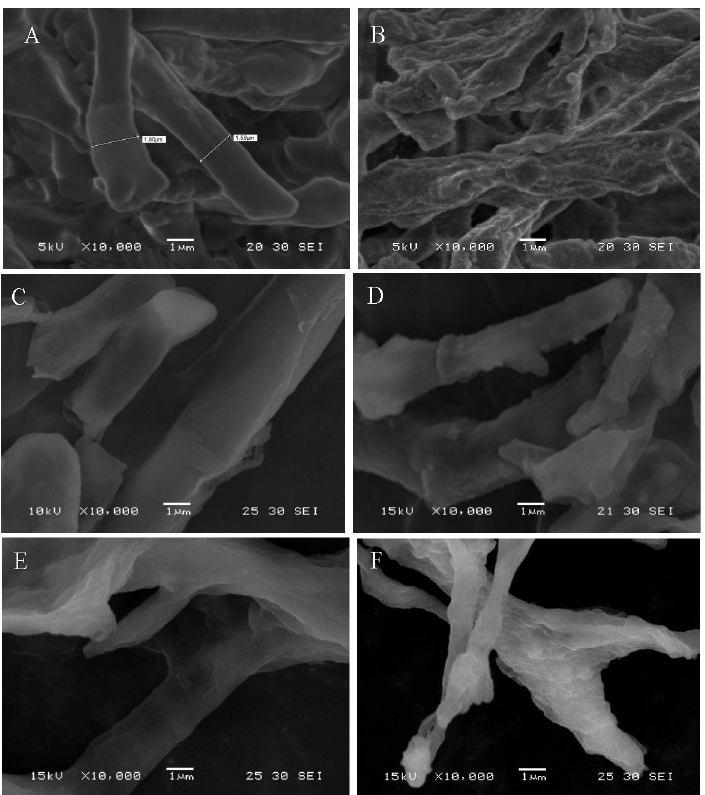
Fig 5. SEM micrograph of growing Verticillium insectorum J3 under different Pb(II) and Zn(II) concentrations. (a) Metal-free pellet (control); (b) metal-loaded pellet (300 mg L -1 ); (c) metal-free hypha (control); (d), (e), (f) metal- loaded hyphae (100, 200, 300 mg L -1 , respectively). Biosorption conditions: initial pH = 4, initial Pb(II) and Zn(II) concentration (0, 100, 200, 300 mg L -1 , respectively), absorption time 7 days, initial biomass does 2mL L -1 , temperature